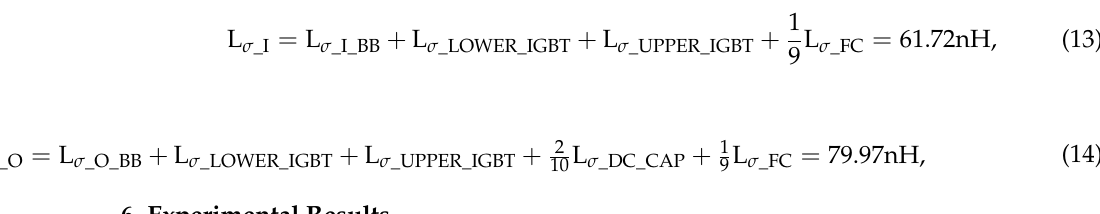
Figure 17. A Simplified schematic of the double ‐ pulse test bench for the FC ‐ 3L ‐ BDC phase ‐ leg PEBB in buck mode.